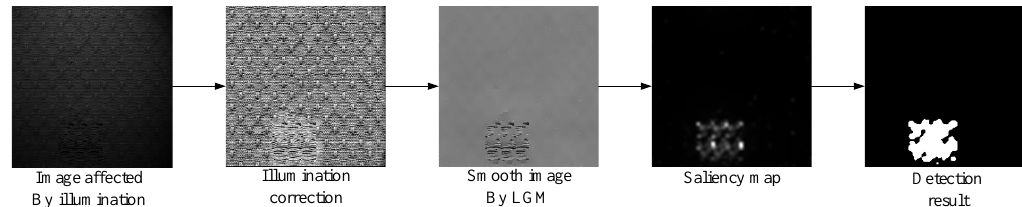
Figure 1. Framework of the proposed our